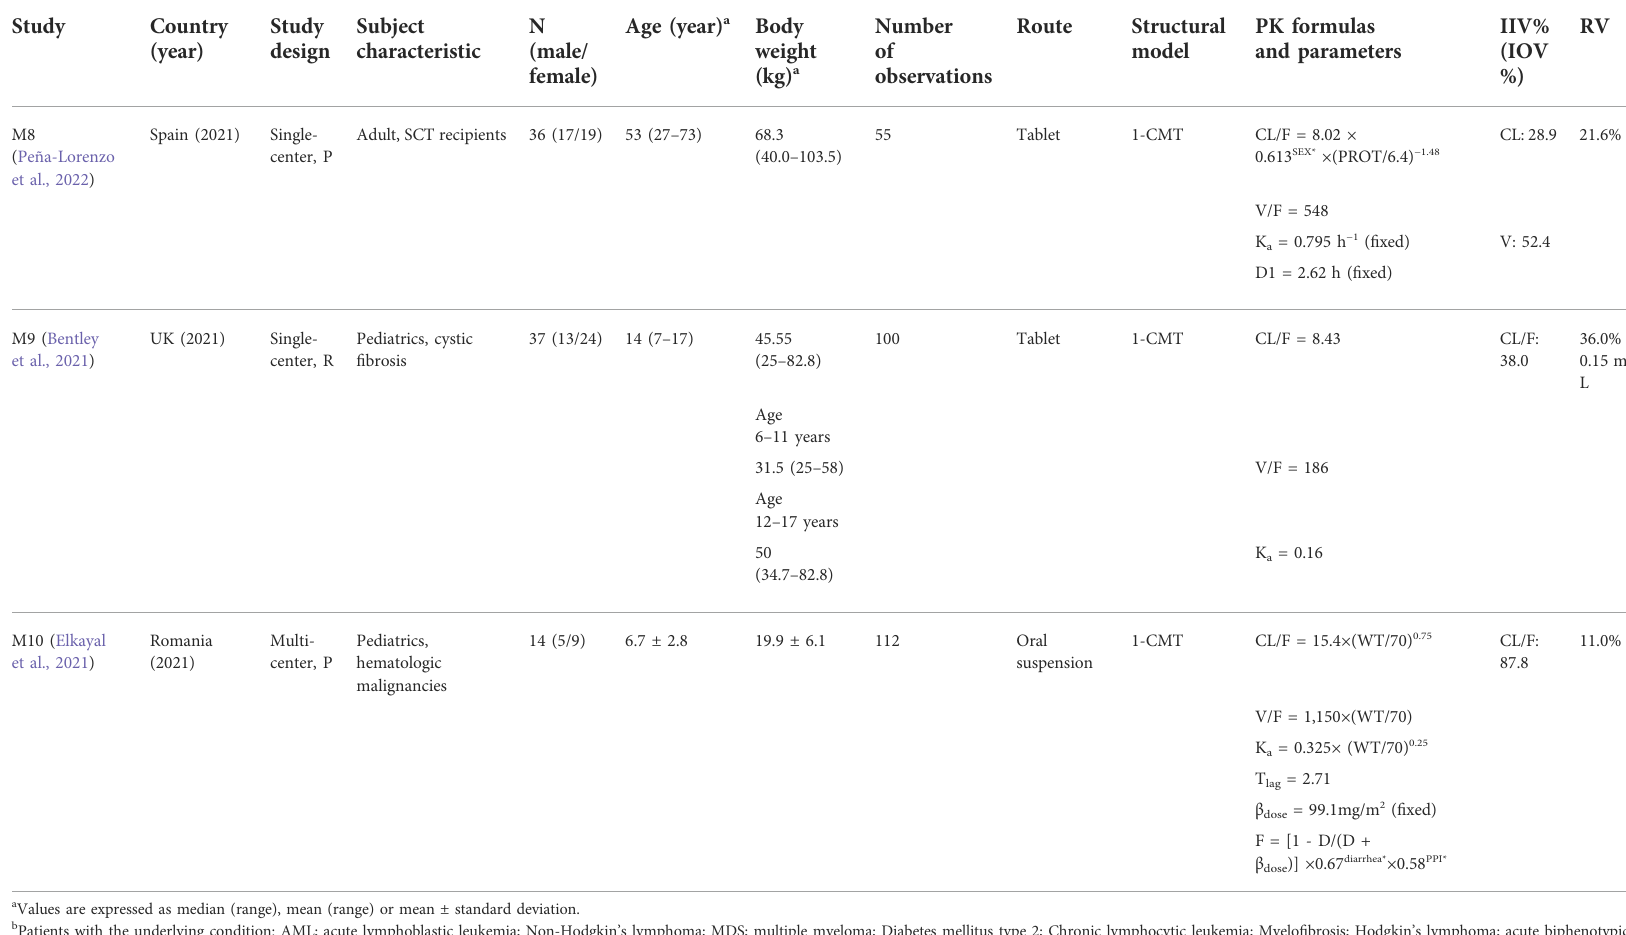
TABLE 1 ( Continued ) Summary of published population pharmacokinetic studies of